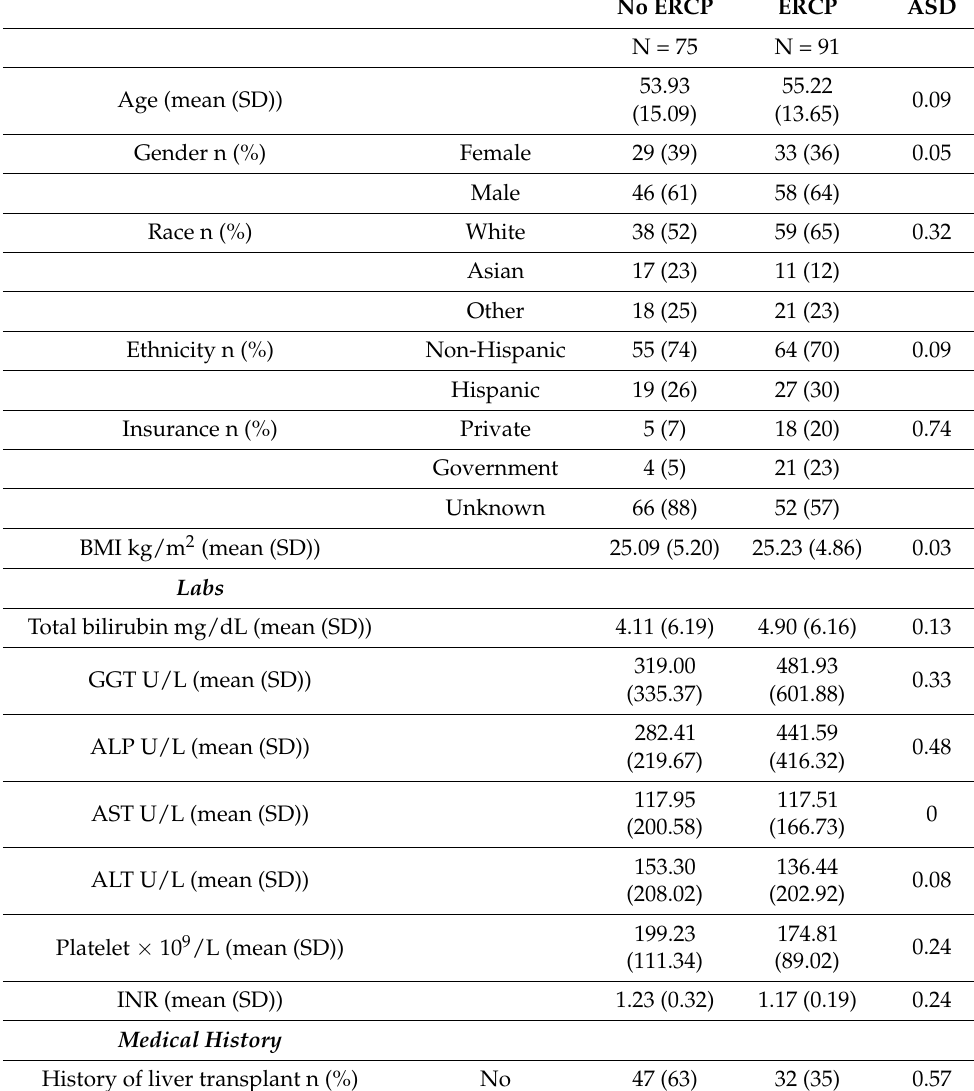
Table 2. Demographics and clinical characteristics stratified by whether ERCP was